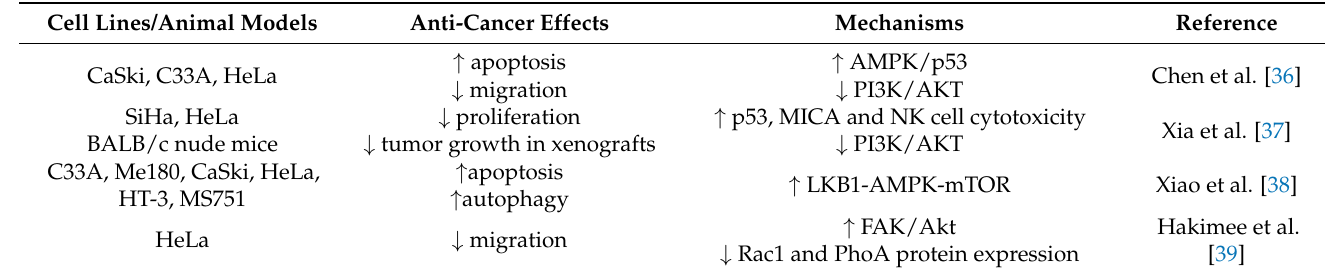
Table 1. Efficacy of metformin on cervical cancer